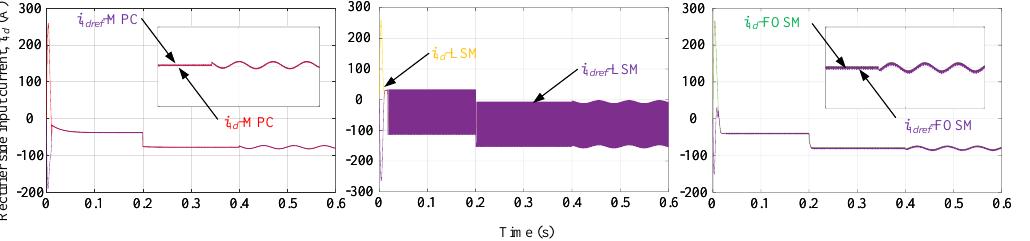
Figure 10. Therectifier-side d -axis current responses under the MPC, the LSM and the FOTSM.